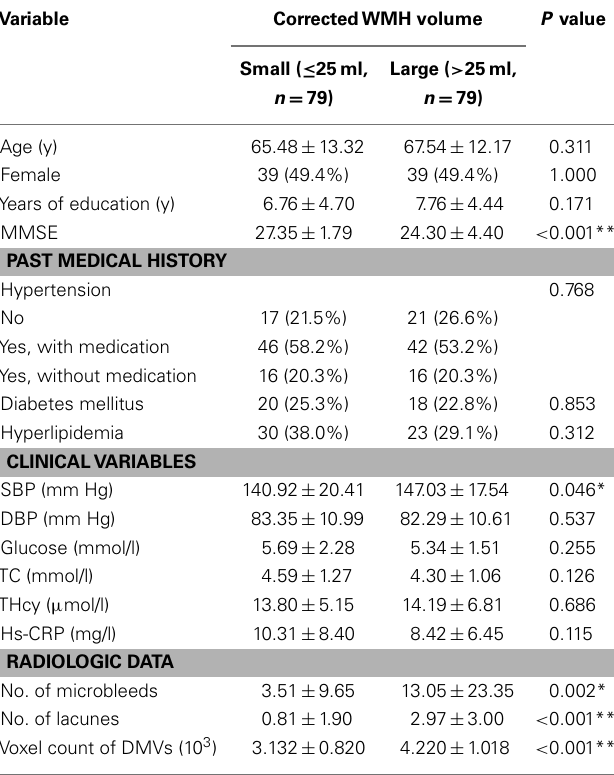
Table 1 | Baseline characteristics ofWMH patients classified according to correctedWMH volume dichotomized at the median .